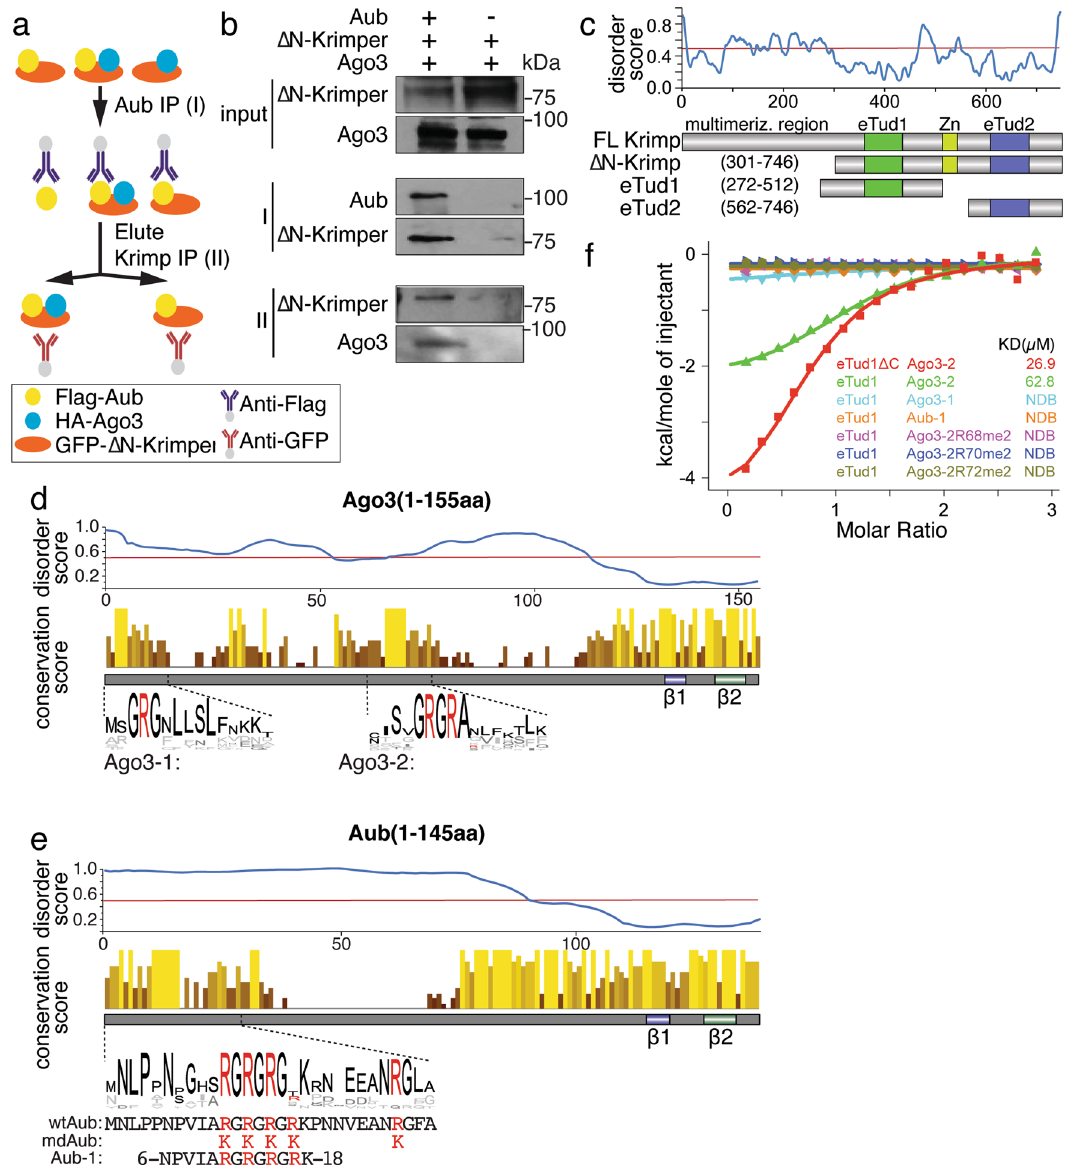
Fig. 1 Krimper monomer simultaneously binds N-terminal regions of Aub and Ago3. a Scheme depicting two-step sequential immunoprecipitation. FLAG-tagged Aub, HA-tagged Ago3, and GFP-tagged truncated Krimper lacking its N terminal dimerization domain were co-expressed in the S2 cell. FLAG-immunoprecipitation was followed by elution and GFP IP. b Krimper monomer interacts with Aub and Ago3 simultaneously. Western blot detection of FLAG-Aub, HA-Ago3, and GFP-deltaN-Krimper in input and after the fi rst FLAG- and second GFP-IP. Experiment reproduced twice with similar results. c Top: protein disorder prediction of Krimper. Bottom panel: domain architecture of Krimper and constructs used for ITC and structural analyses. d Conservation analysis of Ago3 (1-155aa). Top: disorder prediction of Ago3 (1-155aa). Middle: conservation score of each amino acid within Ago3(1- 155aa). Conserved RG-repeat regions are. Bottom: peptides used for ITC and structural analysis. e Conservation analysis of Aub (1-145aa). Top: Disorder prediction of Aub (1-145aa). Middle: conservation score of each amino acid within Aub(1-145aa). The conserved RG-repeat region is enlarged. Bottom: sequence difference between wtAub and mdAub. Five arginines within the N terminus were replaced by lysines. Aub-1 peptide used for ITC and structural analysis. f eTud1 preferentially binds unmethylated Ago3. ITC analysis of Krimper eTud1 with different Ago3 or Aub